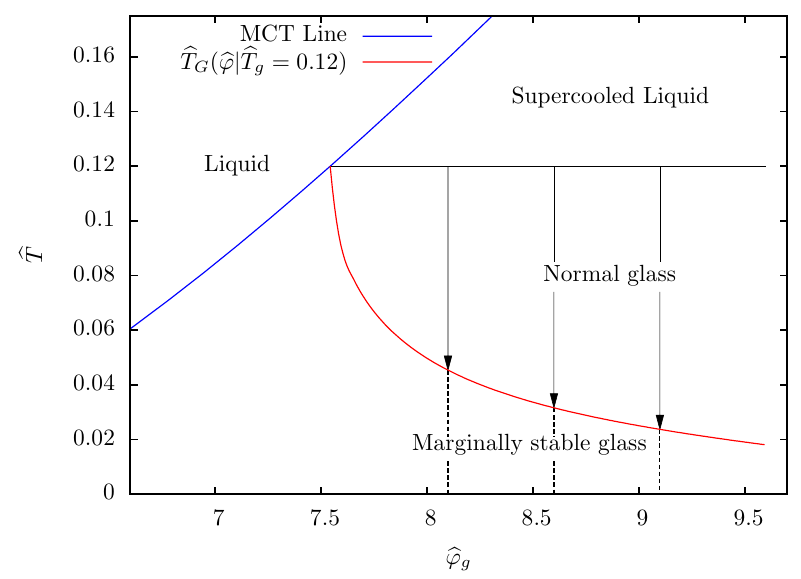
ϕ = 0.12 ) . Again , (cid:98) T (cid:98) g g